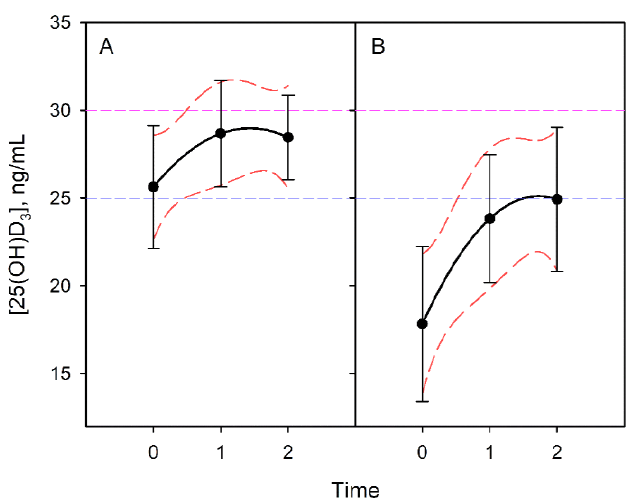
Figure 8. Evolution of vitamin D content in nonsupplemented individuals ( A ). The graph presents the lines of regression of the contents and their slopes. Active supplementation ( B ) did not guarantee levels of sufficiency in these patients.